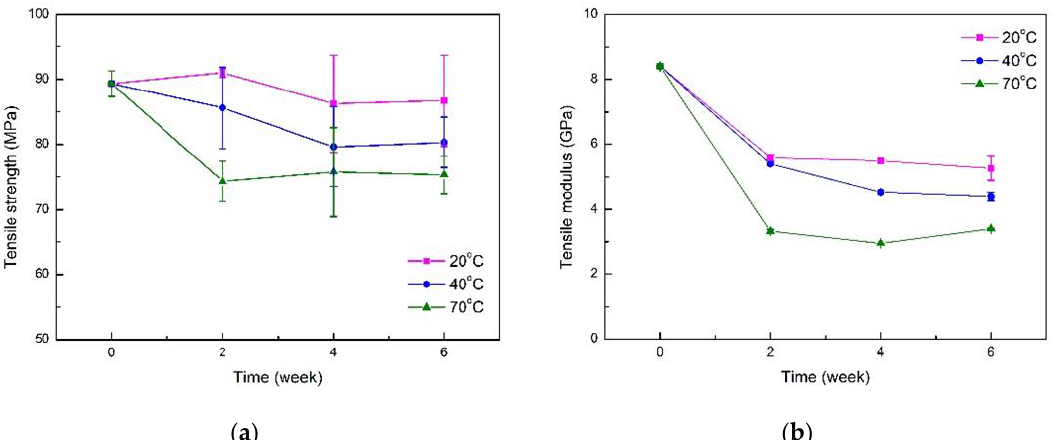
Figure 11. Effect of the water absorption on the tensile properties: ( a ) tensile strength ( b ) tensile modulus for nano-clay grafted FFRPs at different temperature under 80% RH. modulus for nano-clay grafted FFRPs at di ff erent temperature under 80% RH.